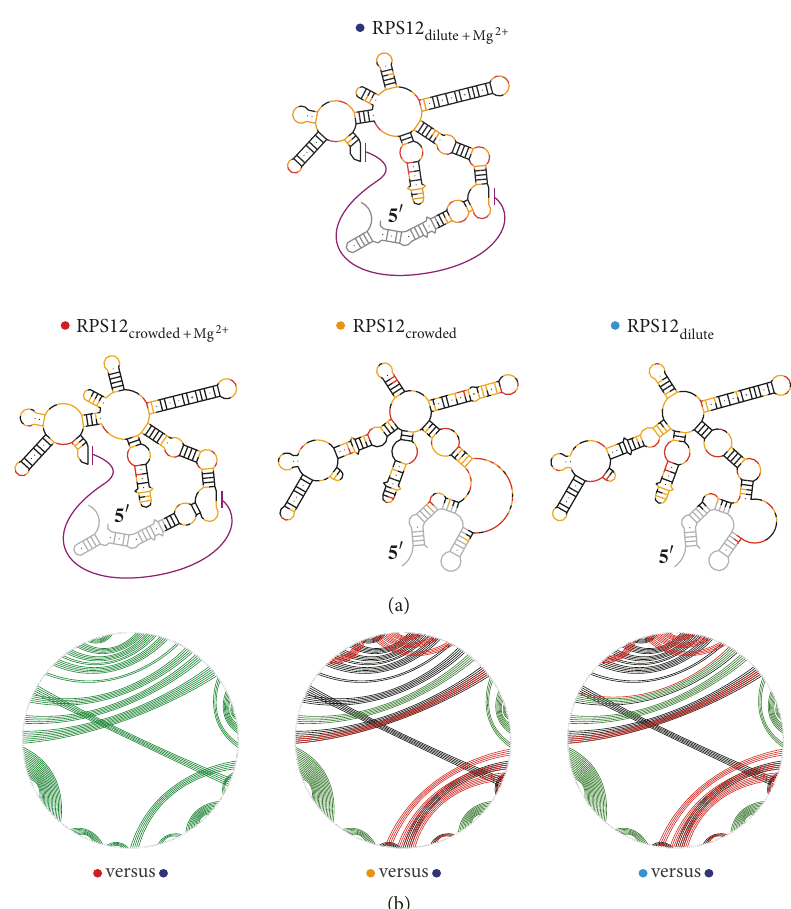
Figure 3: (a) SHAPE-derived minimum free energy (MFE) 2D structures of the RPS12 pre-mRNA: top, at dilute solvent conditions in the presence of 2mM Mg 2+ ; bottom, at crowded solvent conditions in the presence/absence of 2 mM Mg 2+ . (b) Circle-plot comparison of